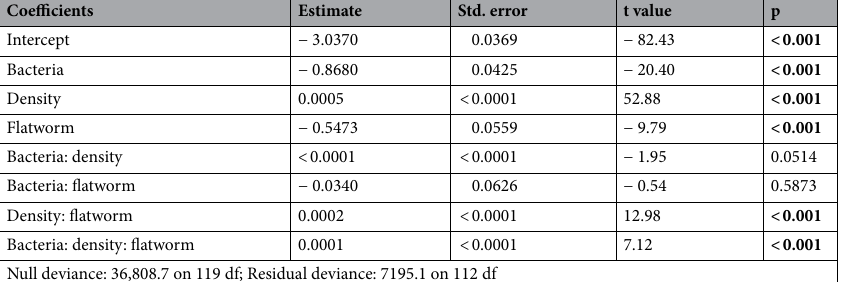
were added. As it was shown that only large nematodes emigrate (see “Results” section), the experiment was run with large individuals for 12 h after the SCs had been prepared. In preliminary experiments, the test chambers were checked once an hour during the first 6 h of the experiment and then after 12 and 24 h. The continuous increase